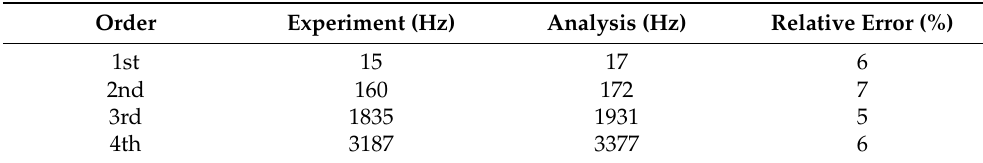
Table 3. Comparison between experimental and analysis results for natural frequencies of a dual rotor.